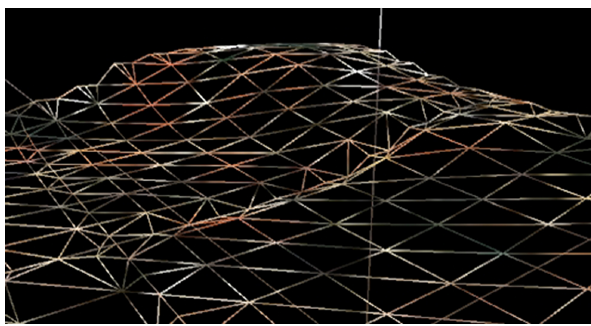
Figure 15. Smooth view of whole surface